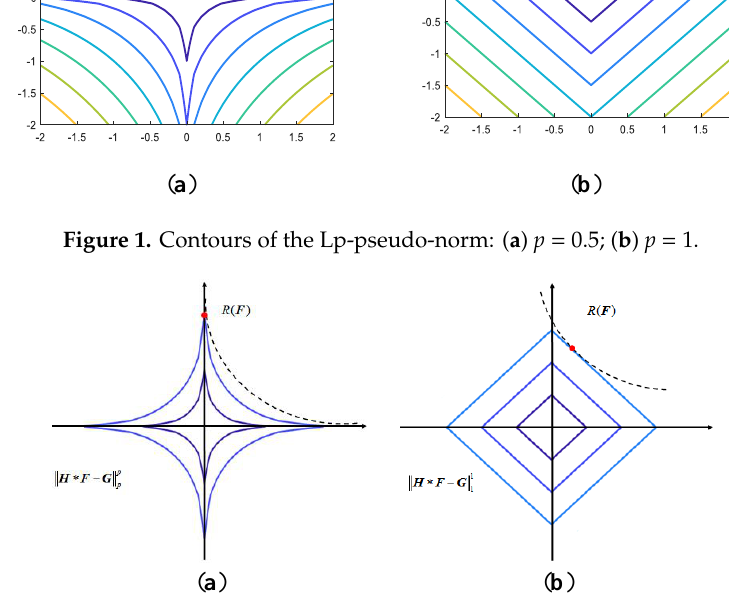
Figure 2. Feasible domain under the Lp constraint: ( a ) p = 0.5; ( b ) p = 1.